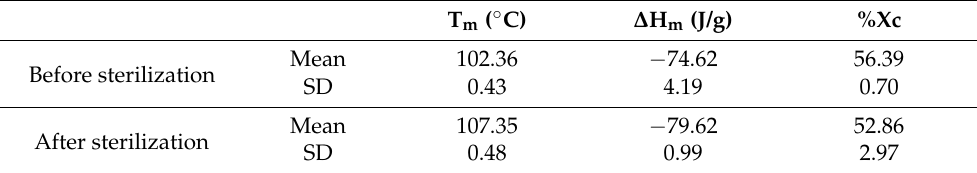
Table 2. DSC analysis before and after sterilization of the PDO